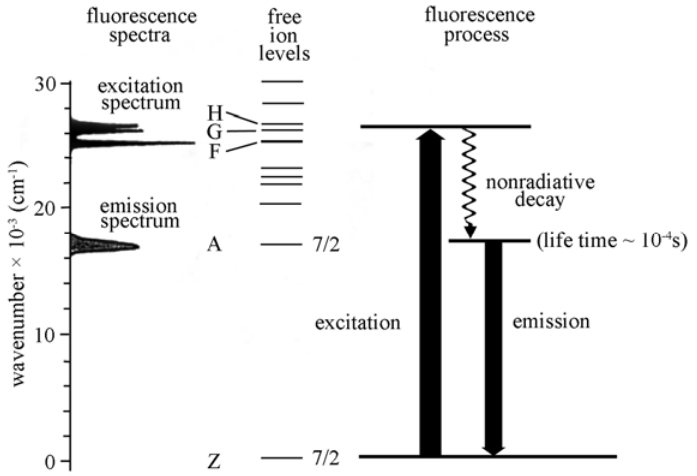
Figure 5. Free ion energy levels of Cm 3+ ions and spectroscopic characteristics